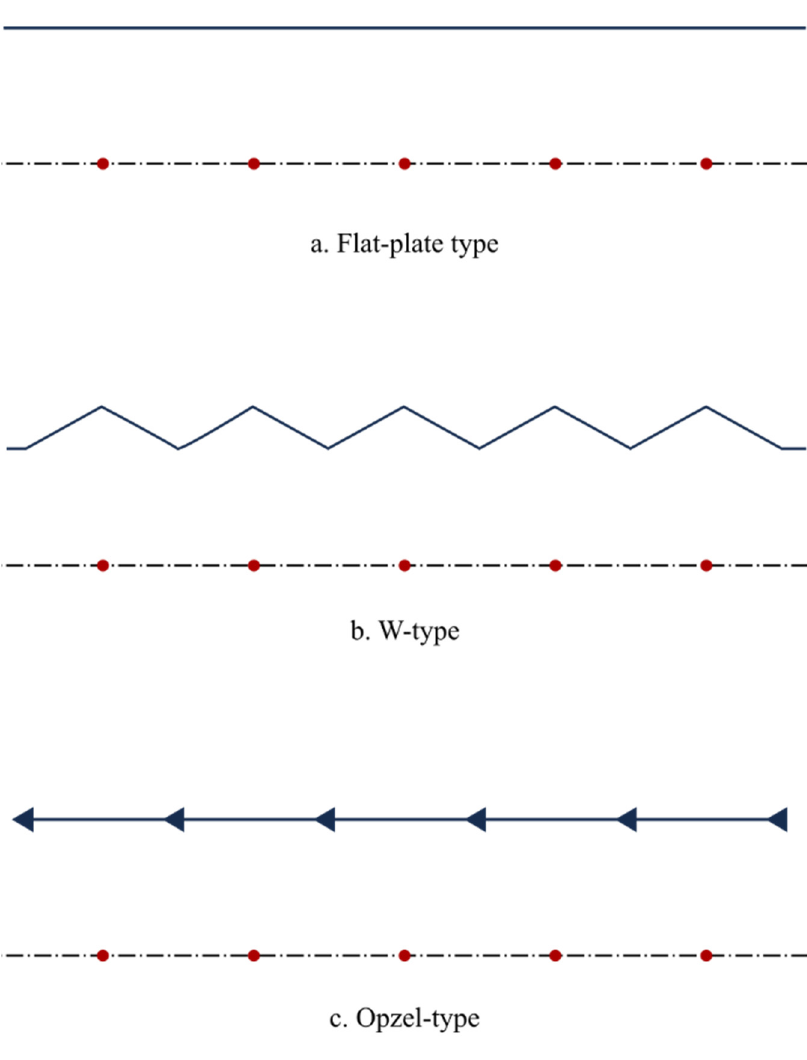
Figure 7. Various collecting plate designs for a wire-plate type ESP.